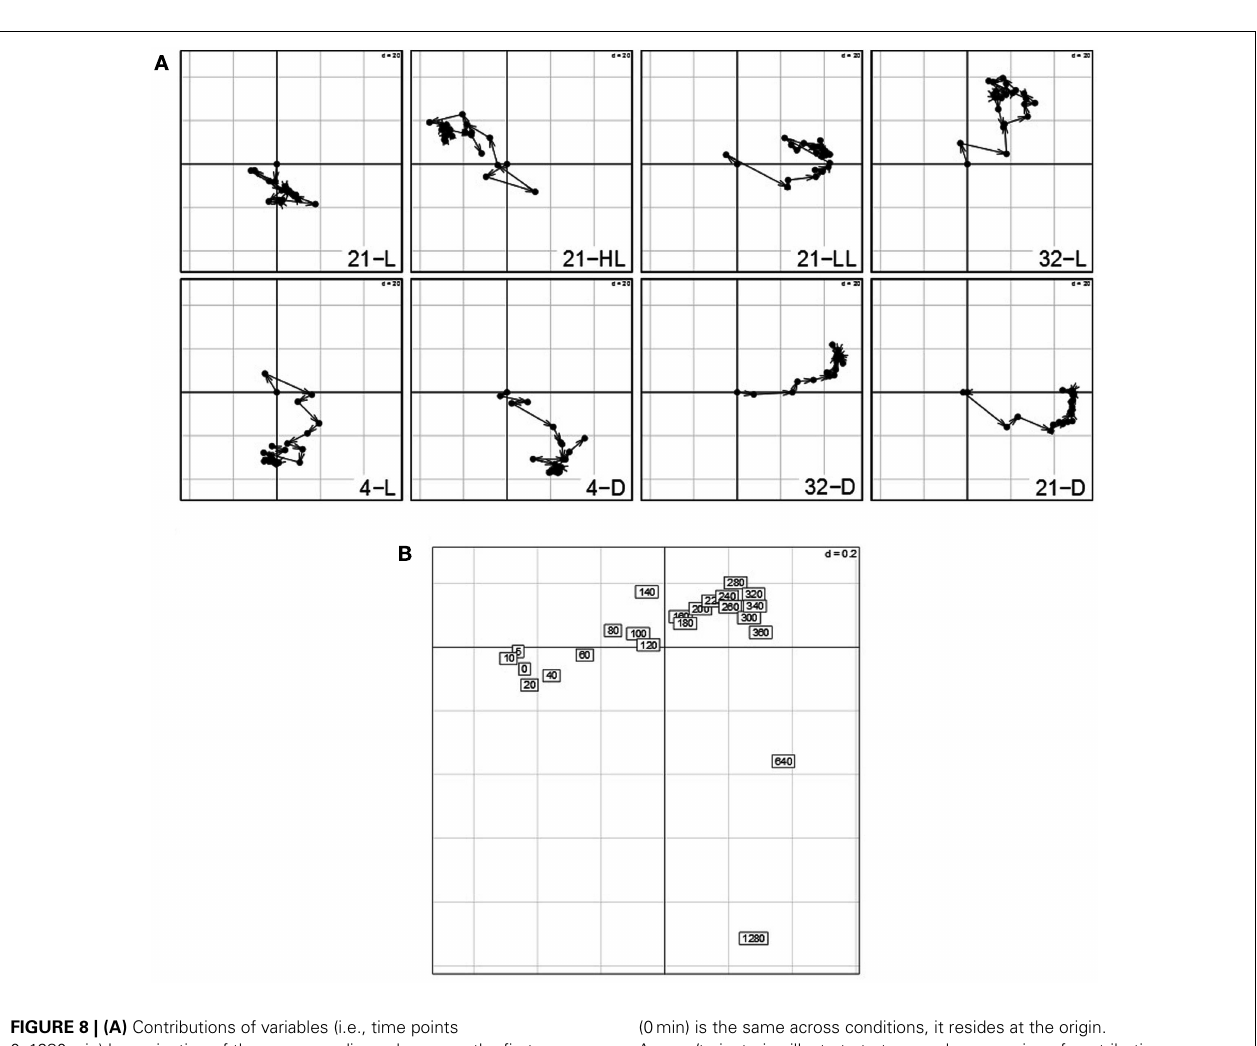
FIGURE 8 | (A) Contributions of variables (i.e., time points 0–1280min) by projection of the corresponding columns on the first and second principal components for each condition (panel 1–8) obtained by using the re-normalized dataset. As the first time point